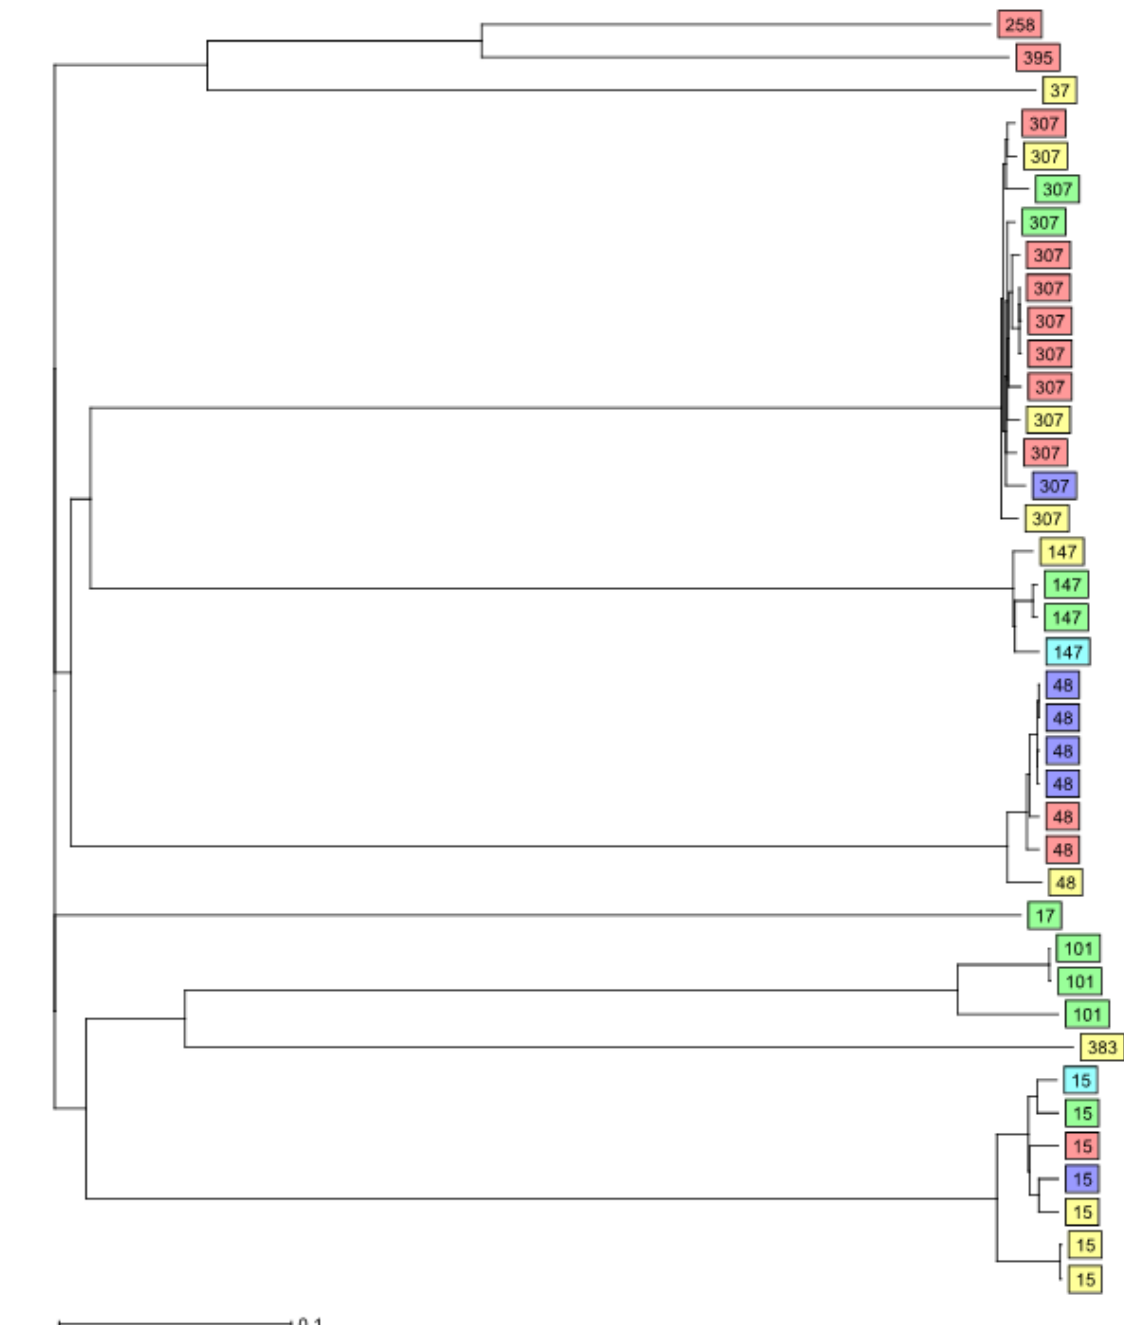
Figure 3. Dendrogram generated using Ridom SeqSphere+ for the HiR 3GCR/CR K. pneumoniae complex bloodstream isolates ( n = 39) coloured by study centre and identified by ST type, ignoring missing values. Each box represents one isolate from an individual patient according to sequence analysis of 2358 cgMLST target genes.